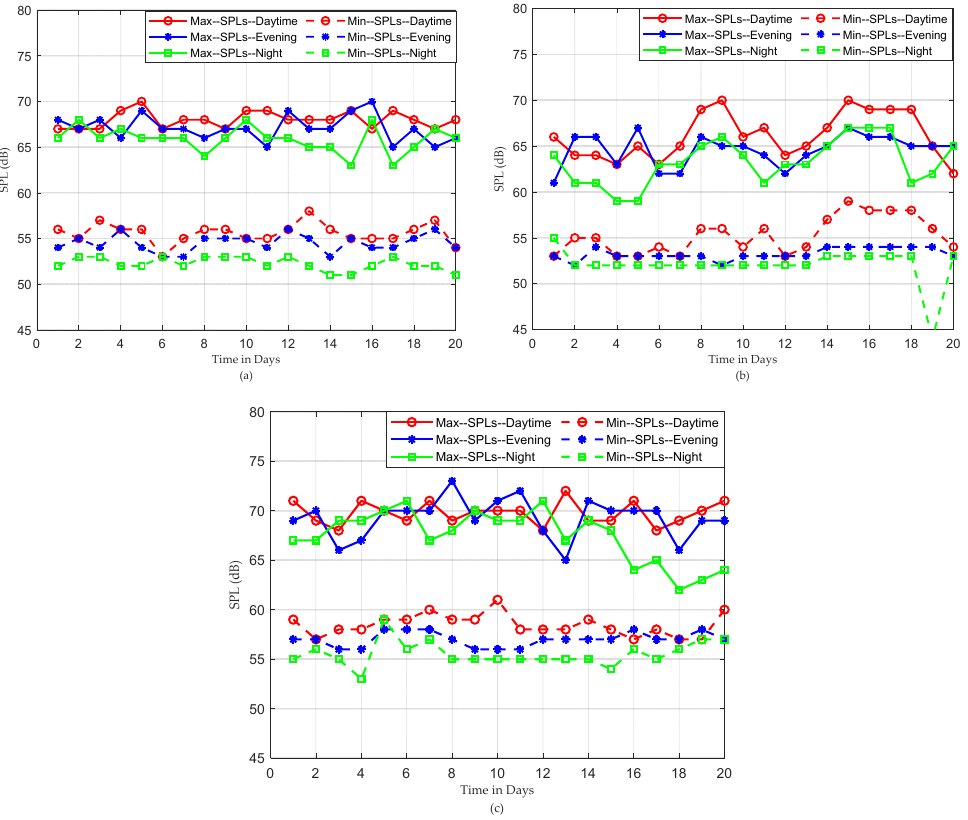
Figure 11. The min and max SPLs during daytime, evening, and night over 20 days for ( a ) ICU1, ( b ) ICU2, and ( c ) ICU3.